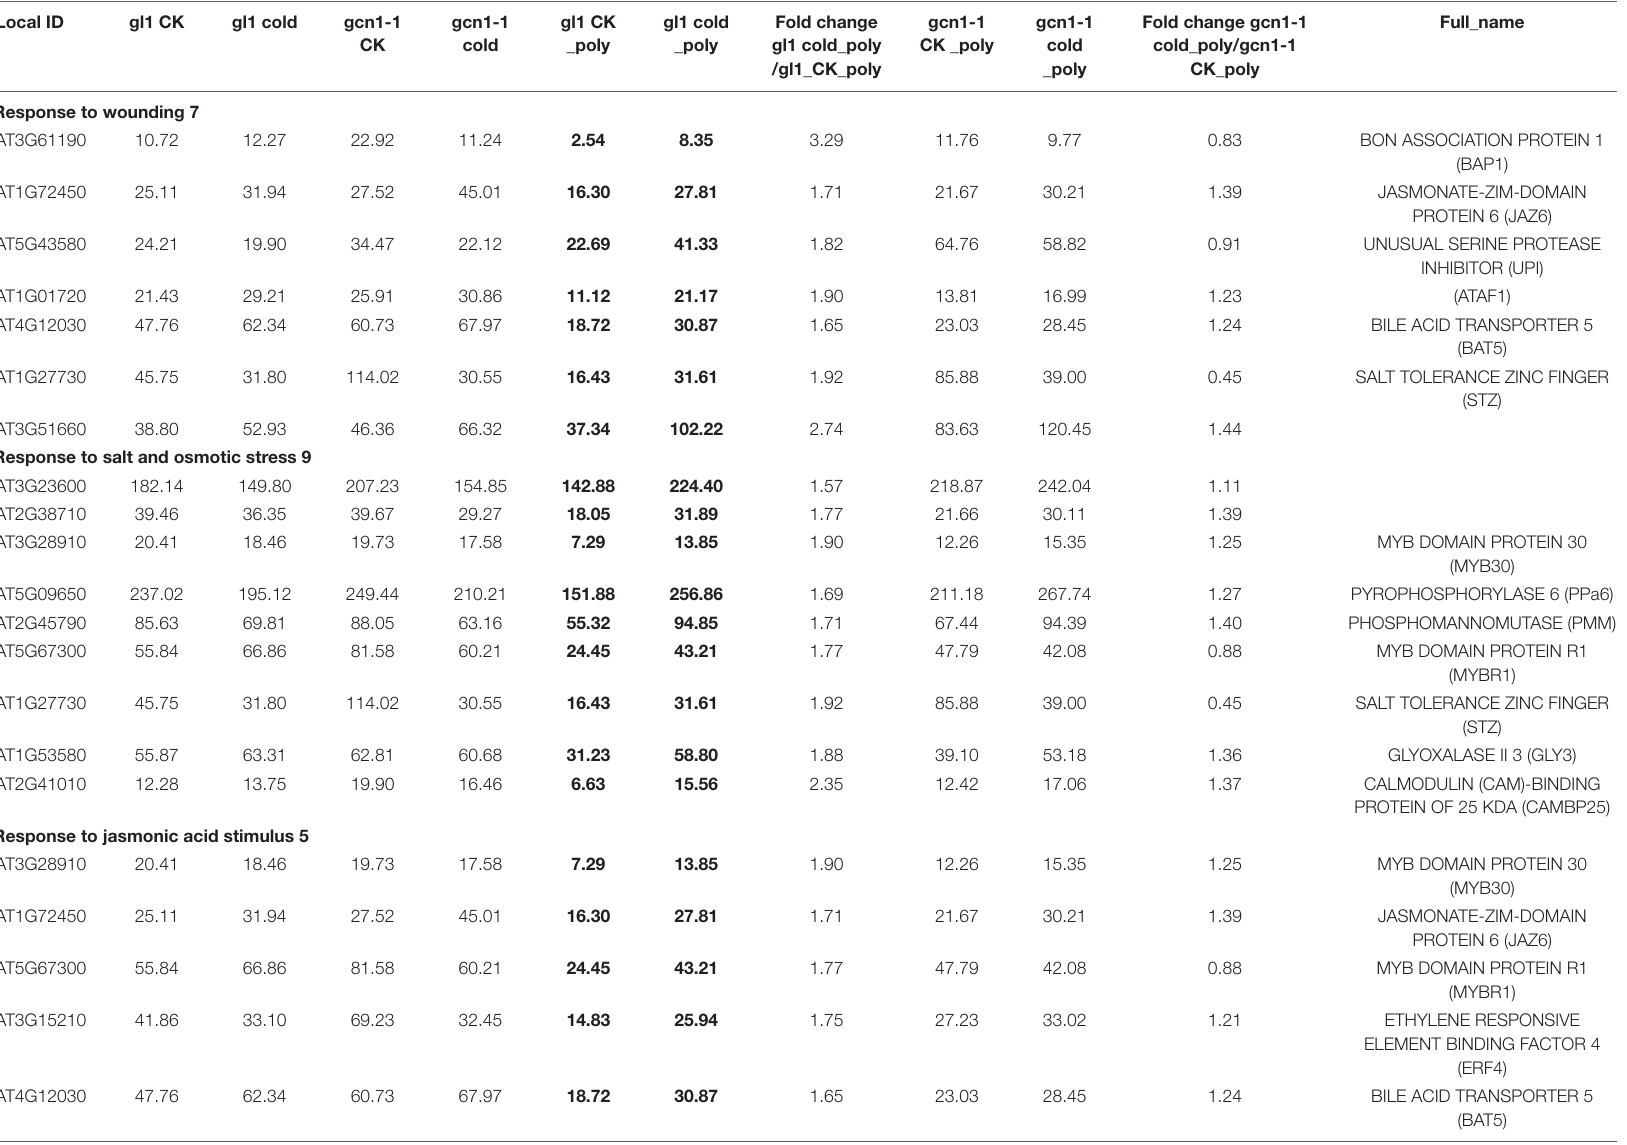
TABLE 4 | Partial classification data of Cold-ATGCN1 up-translated genes. Local